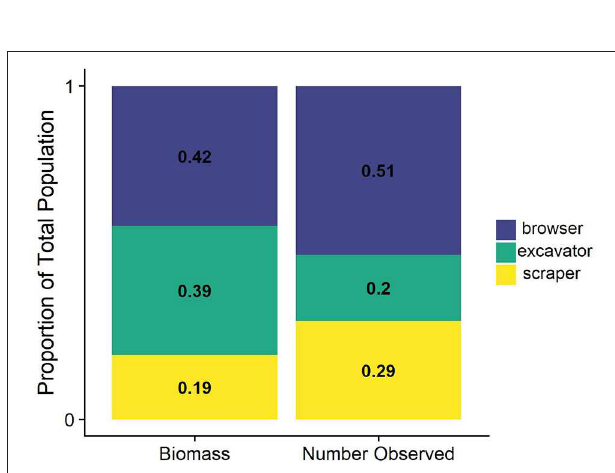
FIGURE 3 | Variation in elkhorn and herbivore populations across survey sites in Akumal, Mexico. Each black dot represents one transect survey (or spur). Blue dots indicate average values at each site with bootstrapped standard errors. On the x-axis, sites are in order of increasing recorded maximum depth (m). The 12m line indicates the separation between the “shallow” and “deep” sets of spur and groove reef areas. (A) Elkhorn tissue LAI (cm 2 ); (B) Diadema urchin density (individuals/m 2 ); (C) Parrotfish biomass (g/m 2 ).